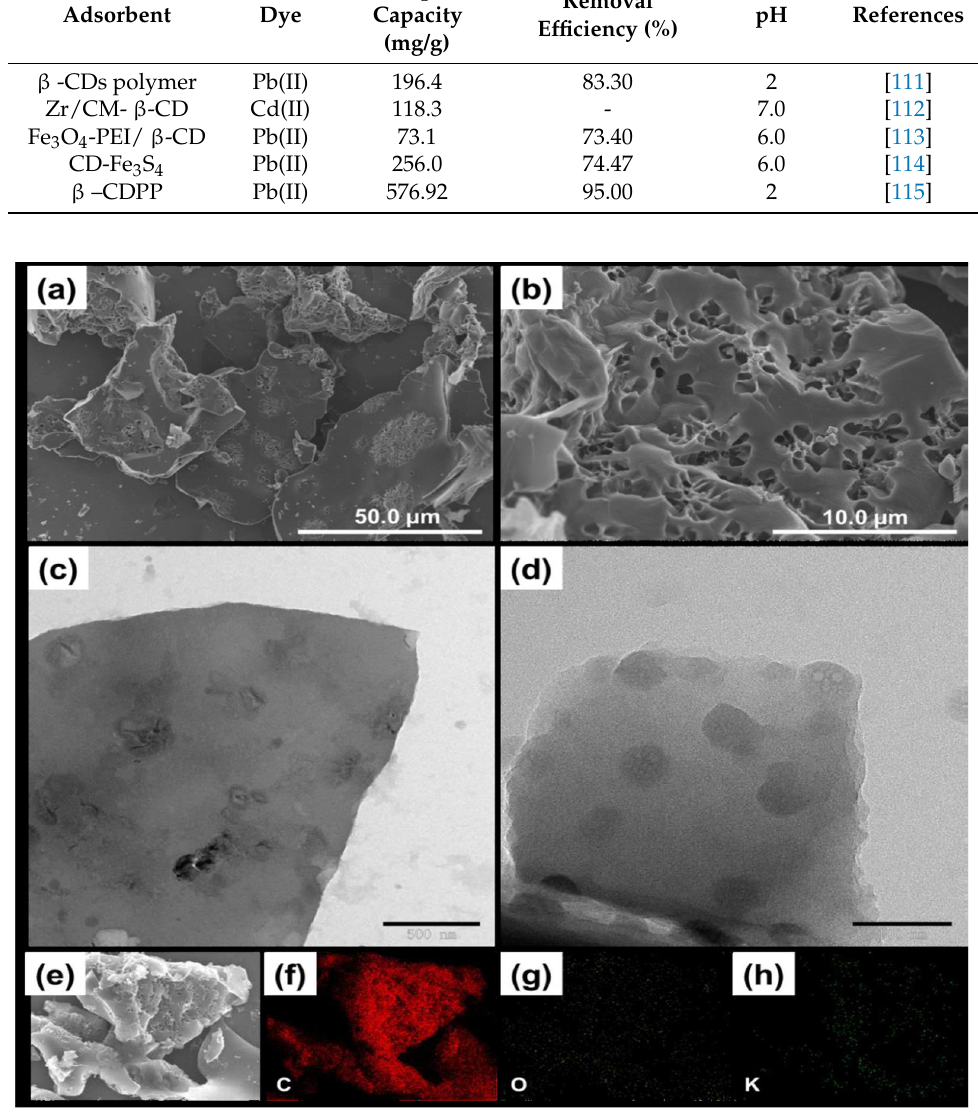
Figure 7. γ-CD MOF-NPC; SEM images ( a , b ), TEM images ( c , d ) and the mapping of C, K and O element( e – h ) [109]. Table 2. Adsorption capacities of various CD-based adsorbents for metals .